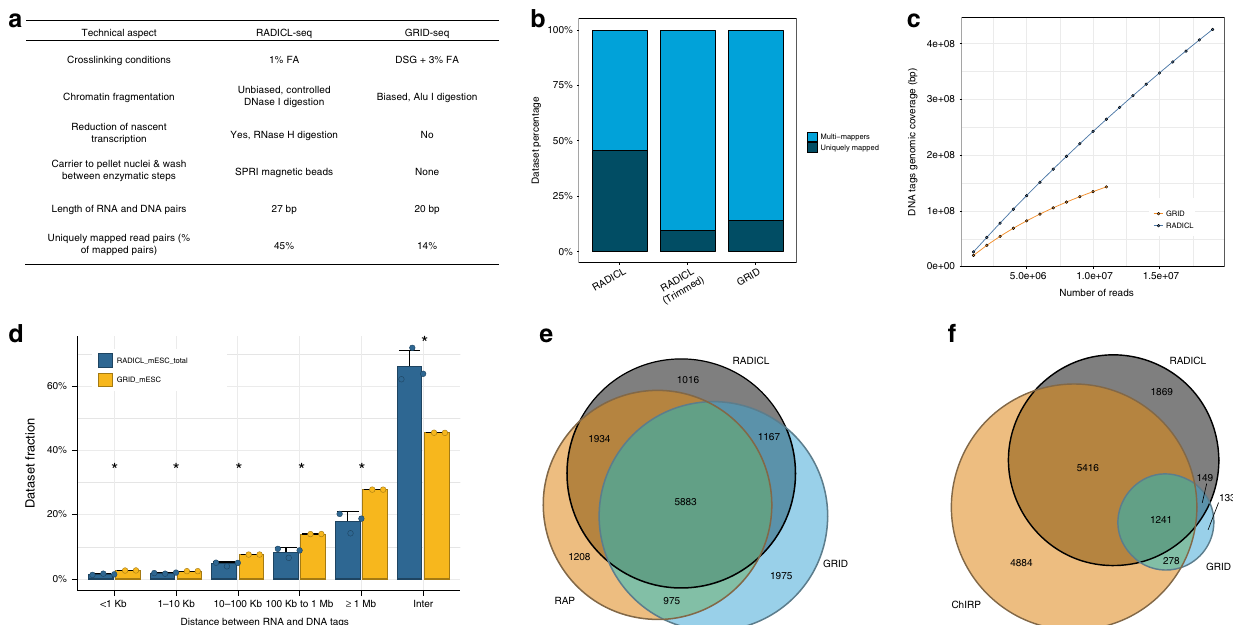
Fig. 2 Comparison of RADICL-seq with similar methods. a Summary of the features that distinguish RADICL-seq from GRID-seq. b Analysis of the read length and mapping outcome. Unique (dark gray) and multi-mapping (blue) reads are reported as percentage of the total number of reads pool. RADICL- seq reads were arti fi cially trimmed down to 20 nt for direct comparison with the GRID-seq dataset. c Assessment of the genomic coverage as a function of the sequencing depth for RADICL-seq (blue) and GRID-seq (yellow). The coverage was calculated for both datasets by sub-sampling with a step of 1,000,000 reads up to the maximum available number of reads. d Distribution of the linear genomic distance between RNA and DNA tags derived from the same read for the GRID-seq (yellow) and RADICL-seq (blue) datasets. Data are presented as mean ± s.d.; statistical signi fi cance was calculated with one- sided two-proportions z test; * P ≤ 0.05. e Comparison of Malat1 transcript target DNA loci in mESCs identi fi ed by RAP-DNA (yellow), RADICL-seq (grey), and GRID-seq (blue) methods. f Comparison of Rn7sk transcript target DNA loci in mESCs identi fi ed by ChIRP-seq (yellow), RADICL-seq (grey), and GRID-seq (blue) methods. All panels were generated using RADICL-seq total dataset. Source data are available in the Source Data